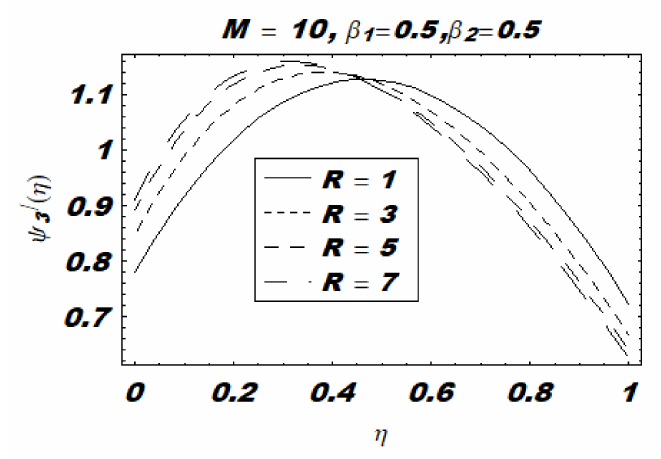
Figure 13. Similarity function ψ /